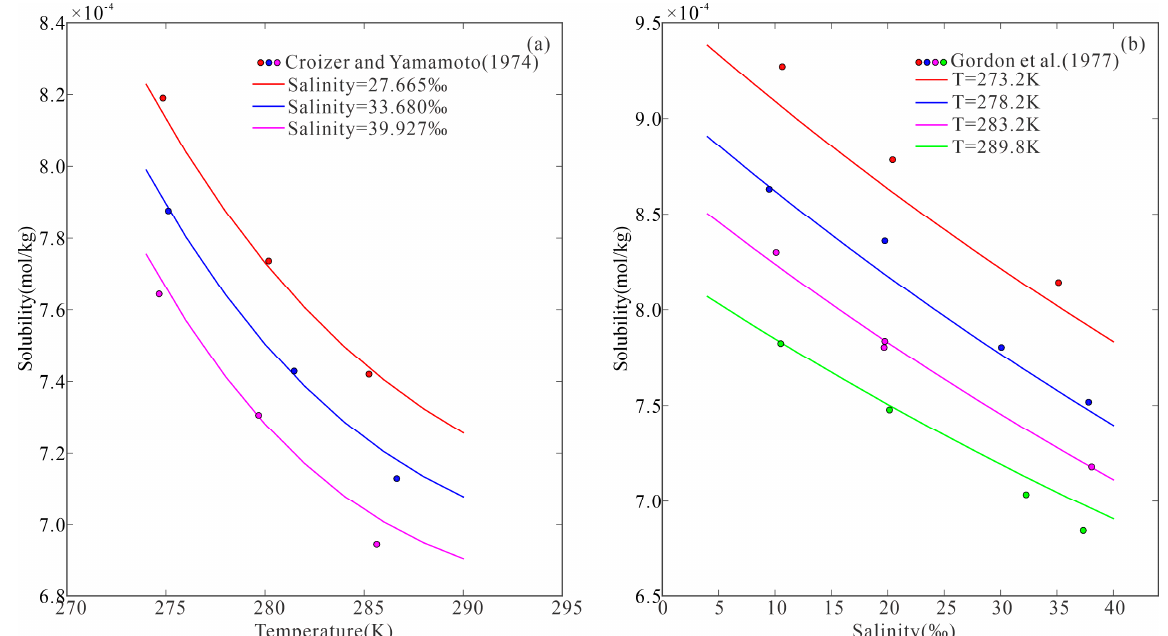
Figure 5. H 2 solubility in seawater versus temperature ( a ) and salinity ( b ). (Solid lines represent the modeled data, and the discrete symbols represent the experimental data